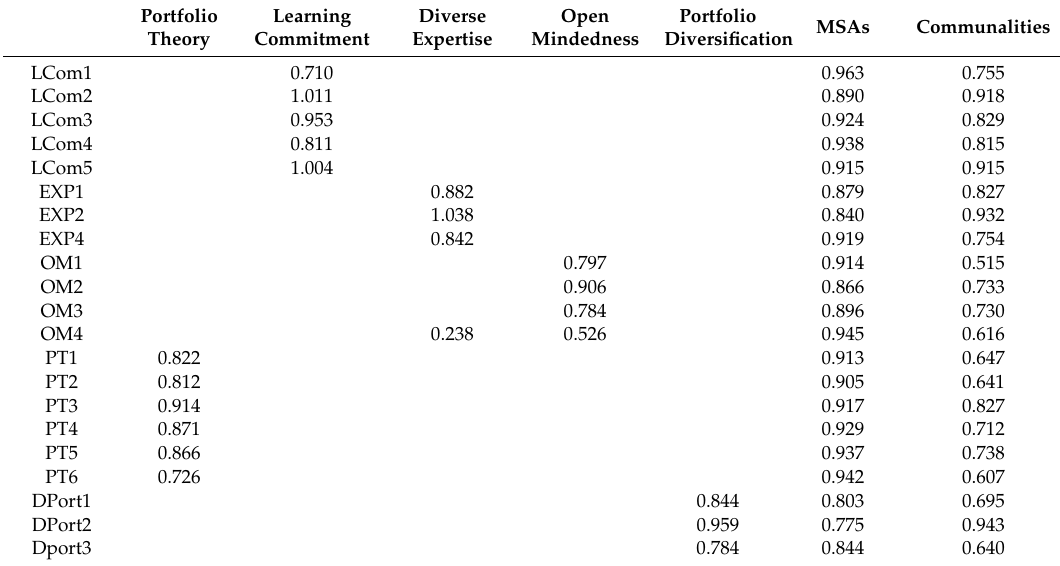
Table A1. Pattern Matrix, MSAs and Communalities of Extracted